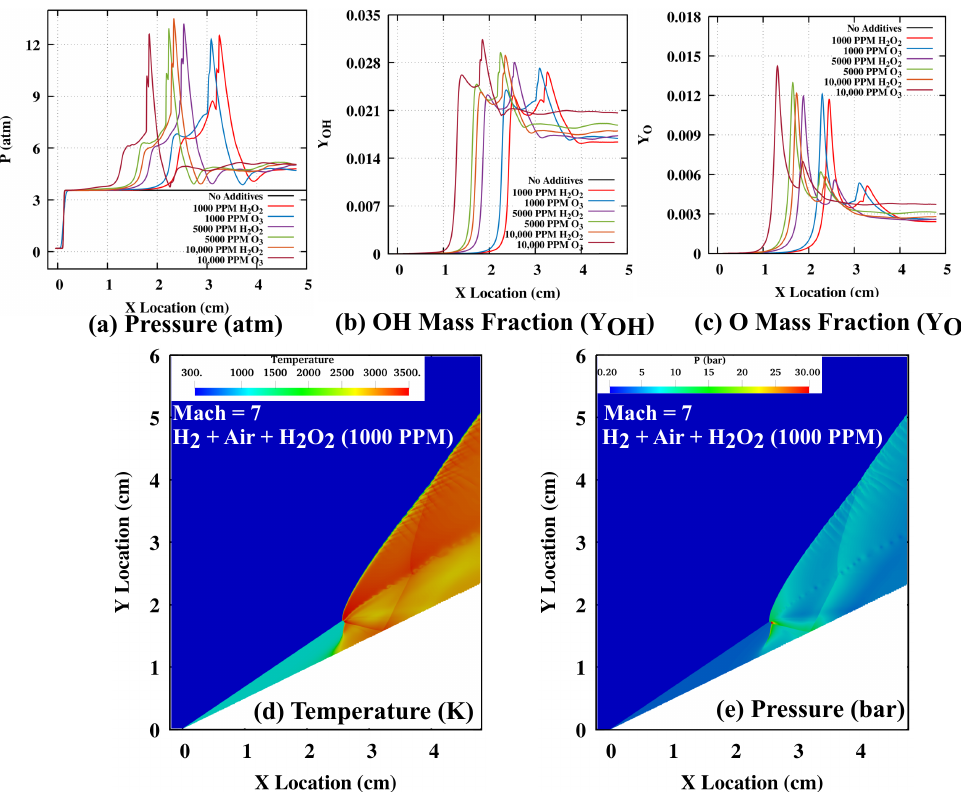
Figure 6. ( a ) Pressure, ( b ) OH Radical Mass fraction, ( c ) O variation along the wedge surface, ( d ) temperature, and ( e ) pressure contour for 1000 PPM H 2 O 2 Addition at Mach